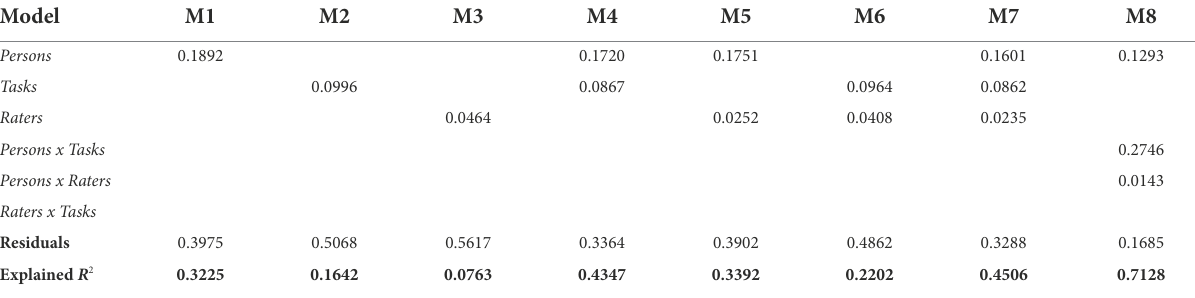
TABLE 3 Results of variance decomposition according to G-Theory using mixed-effect models.